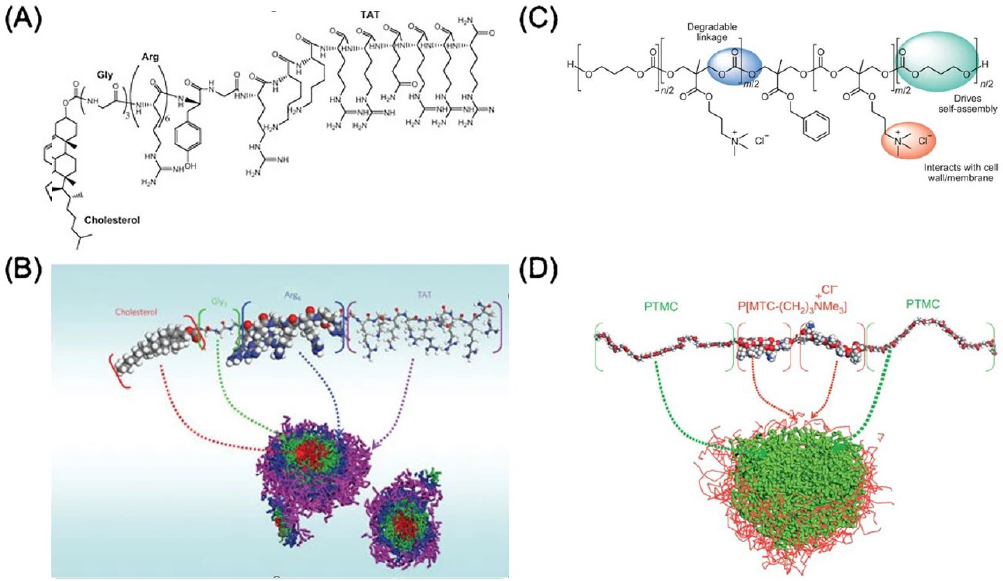
Figure 6. Images ( A ) and ( B ) are the chemical structure of the proposed peptide containing cholesterol, glycine, arginine, and TAT, and represent the formation of micelles. Reproduced with permission from [121], American Chemical Society, 2013. Images ( C ) and ( D ) are the chemical structure of cationic amphiphilic polycarbonate and represent the formation of micelles, as simulated by the Materials Studio program utilizing molecular modeling. Reproduced with permission from [122].